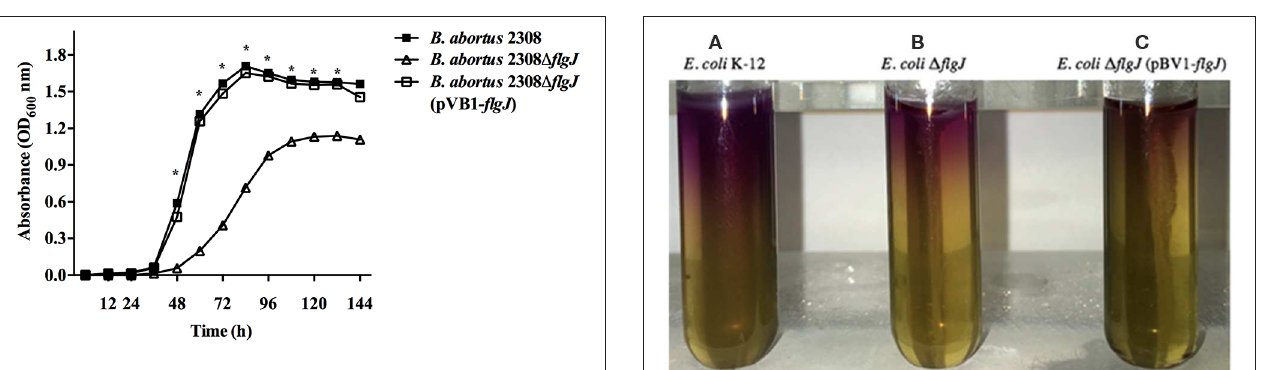
FIGURE 1 | Growth curves of B. abortus strains; B. abortus 2308 (wt), B. abortus 2308 1 flgJ , and complemented 2308 1 flgJ (pBV1- flgJ ). Deletion of flgJ gen in B. abortus 2308 results in a growth deficiency. The absorbance (optical density, OD) was measured under 600nm; the plotted points for each curve was measured at 12h of culture. Results were expressed as mean ± standard deviation (SD), * P < 0.05 significant.